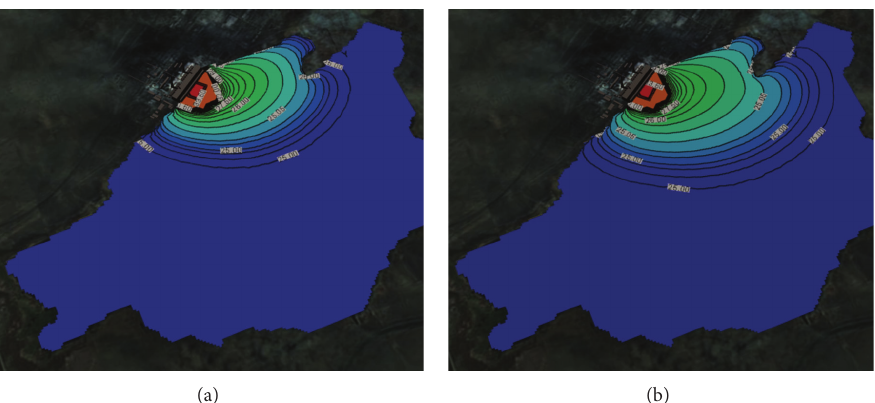
Figure 3: Outline and contours of temperature at 15 and 24 hours at the west wind after the launch of Ekibastuz SDPP-1 on the surface and the side view.